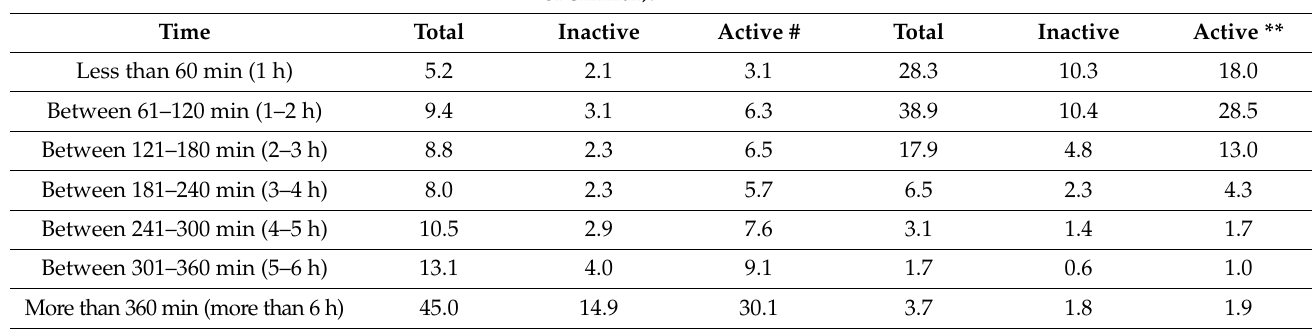
Table 1. Sedentary habits dimension results (%): total, inactive (<150 min/week of PA), and active (>150 min/week of PA).